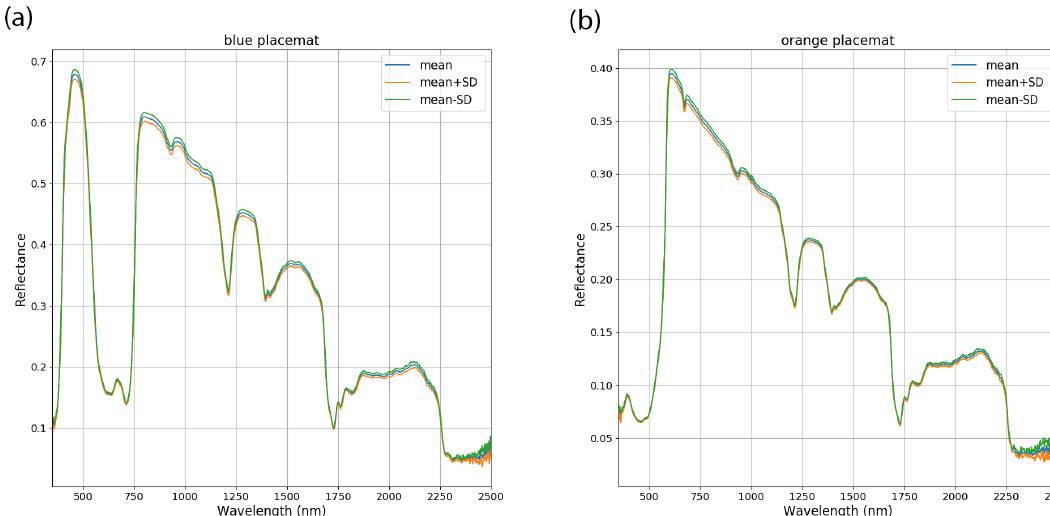
Figure 5. Mean and SD for the dry blue and orange place